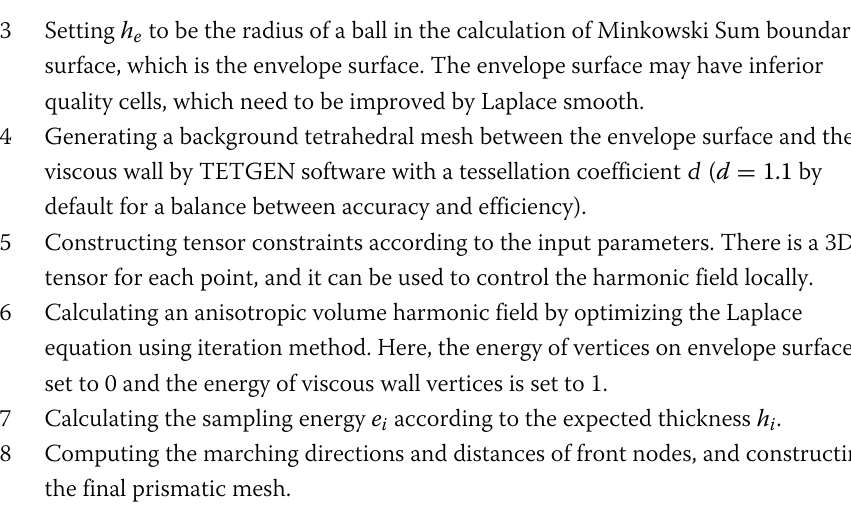
surface, which is the envelope surface. The envelope surface may have inferior quality cells, which need to be improved by Laplace